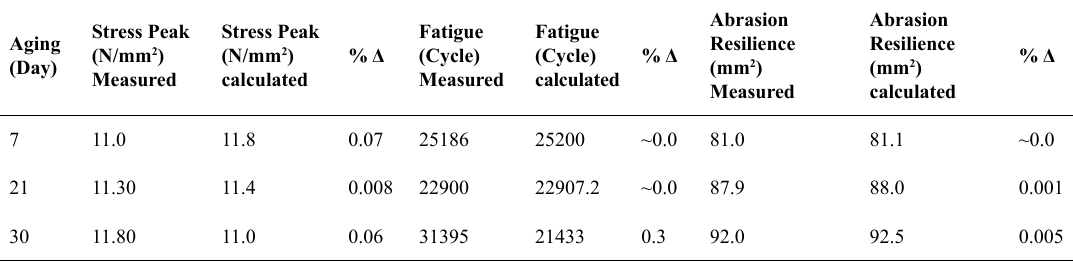
Table 10. Comparison of measured and calculated data of Stress, Fatigue and Abrasion.